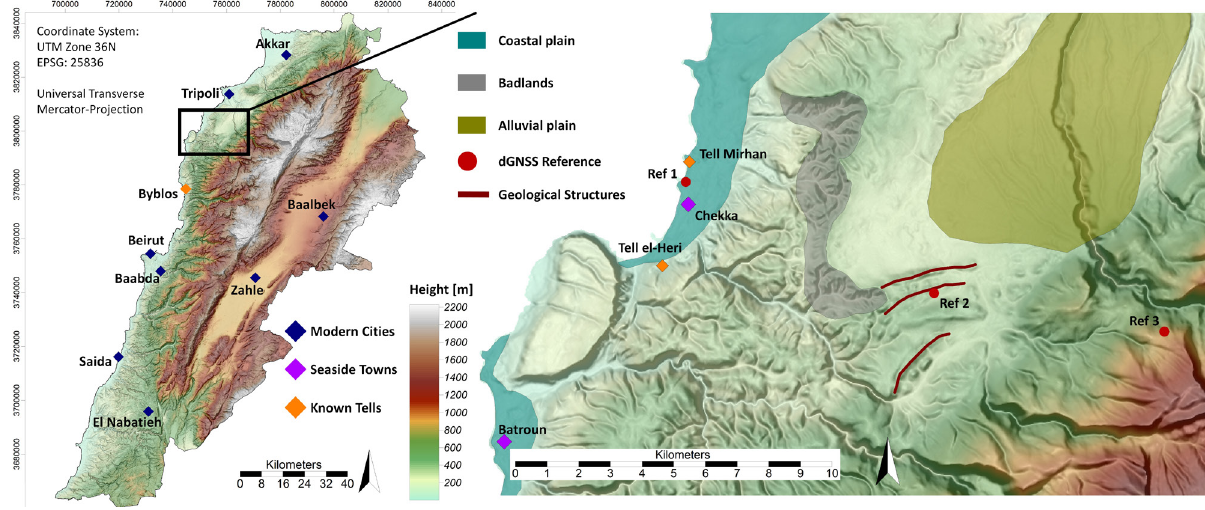
Figure 1: Study area in northern Lebanon. Three geomorphological landscape units are marked in the Chekka region (coastal plain, badland area, alluvial plain of the Abu Ali River). The locations of the dGNSS reference stations are marked as well. The elevation model is based on ALOS Global Digital Surface Model